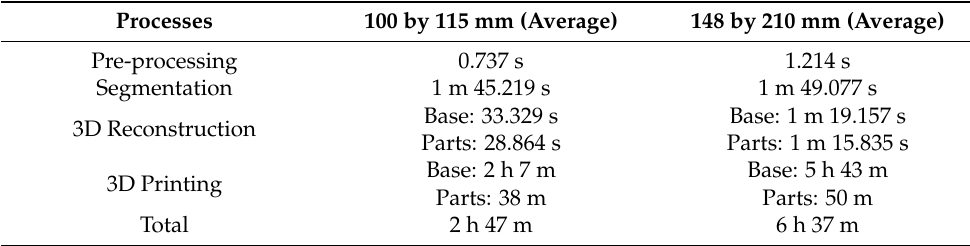
Table 5. Speed of the different processes.